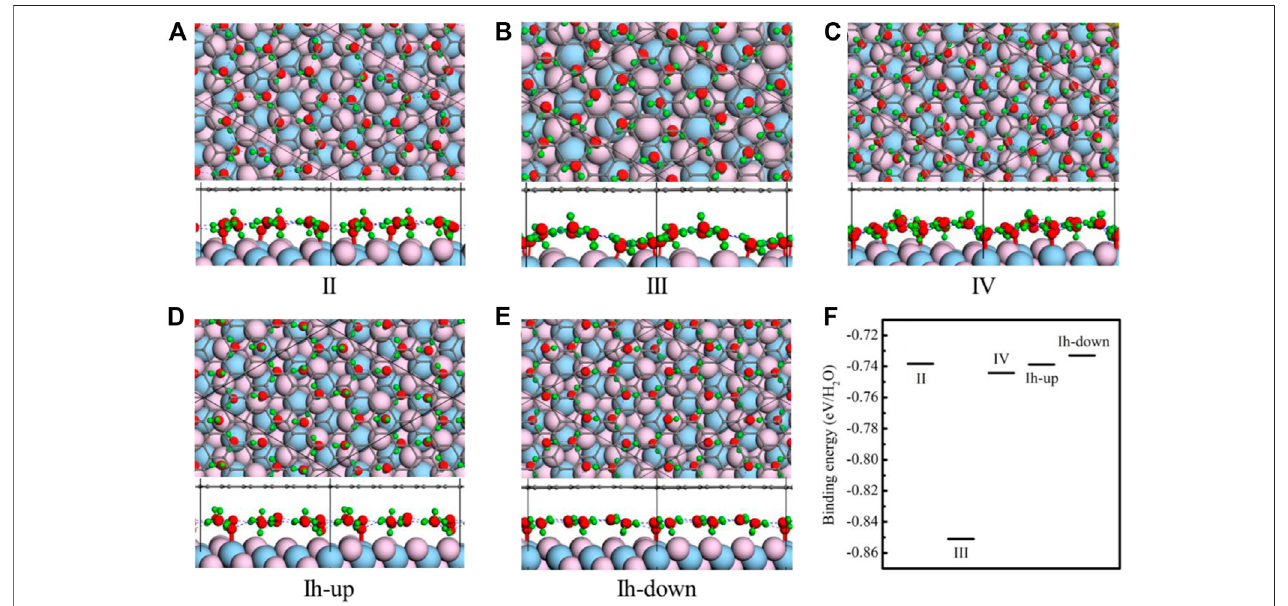
FIGURE 2 | Structures of fi ve ice phases including ice II (A) , III (B) , IV (C) , and Ih (D,E) con fi ned between CaF 2 (111) and graphene. According to the different orientations of OH, ice Ih can be classi fi ed into two kinds. In all panels, the black, red, green, fl esh pink, and light blue spheres represent the C, O, H, F, and Ca atoms, respectively. (F) The binding energiesof monolayer ice phases between the CaF 2 and the graphene system. Light blue spheres represent the C, O, H, F, and Ca atoms,